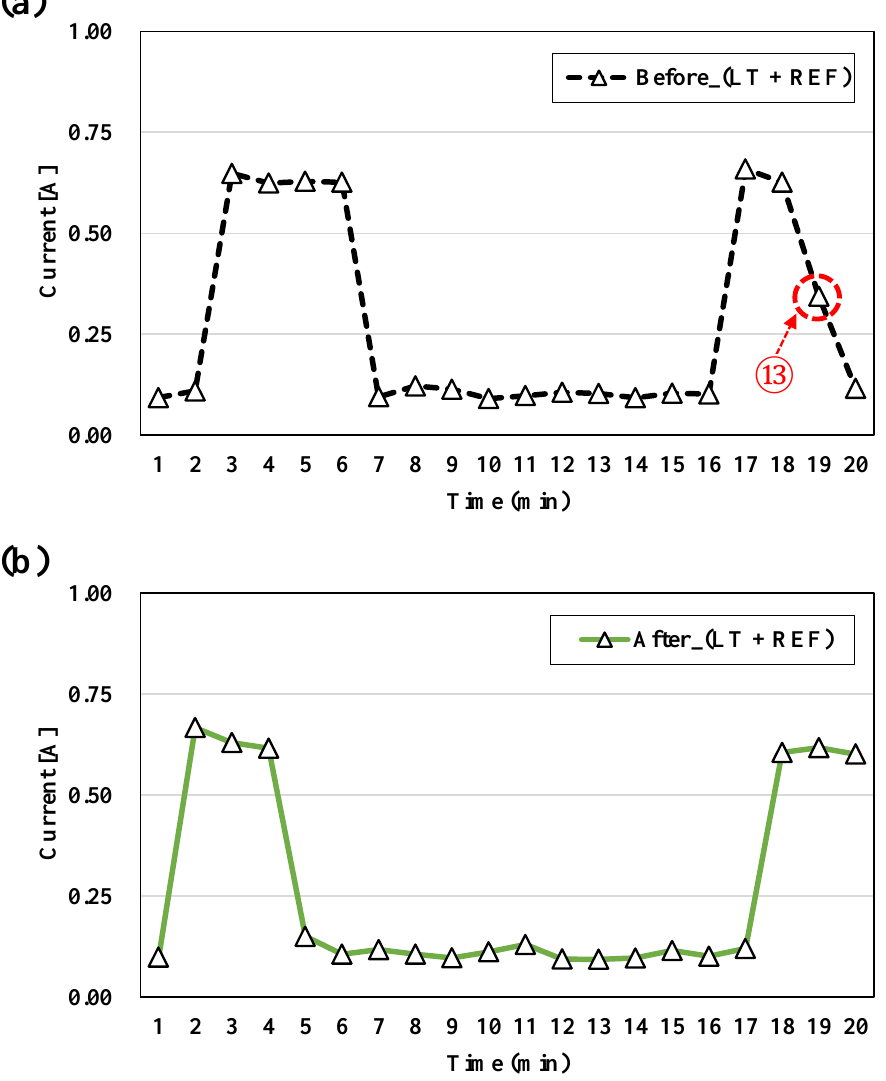
Figure 9. LT + REF usage pattern ( a ) before modification and ( b ) after modification.